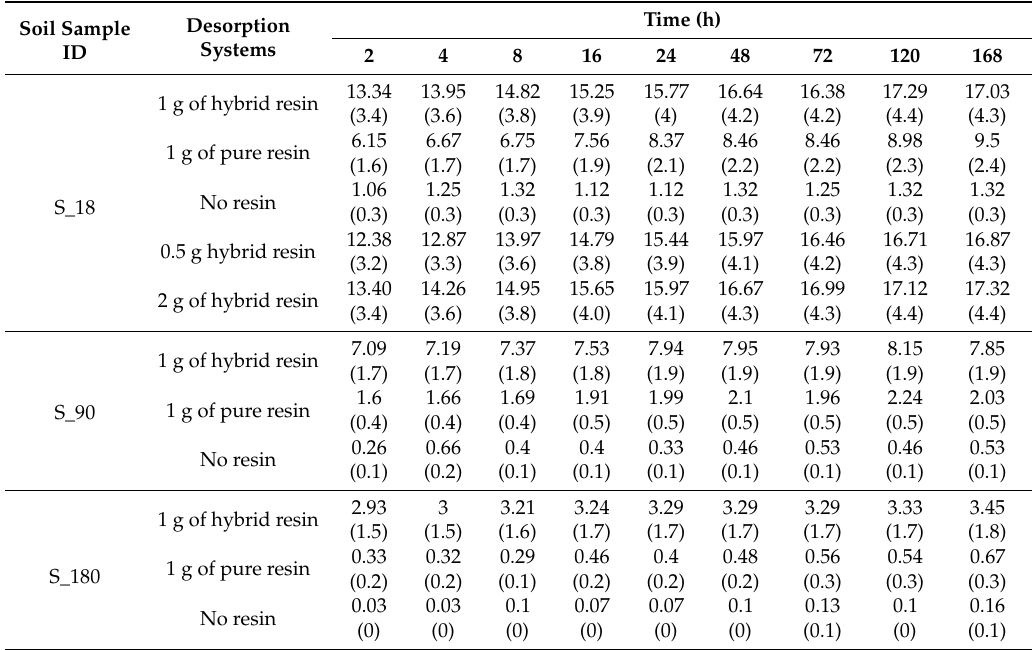
Table 4. Phosphate desorption from P rich soils in di ff erent desorption systems. The total desorbed P is described in mg / kg, and the values in parentheses represent the percentage of total desorbed P with respect to total P in each